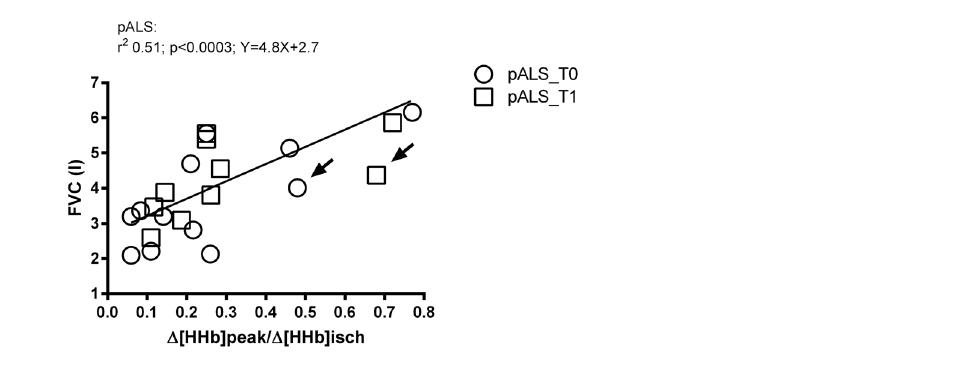
Figure 5. Correlation between orthostatic lung vital capacity (FVC) and vastus lateralis O 2 extraction ( Δ [HHb]/ Δ [HHb]isch) at exhaustion, at baseline (T0) and after 4 months (T1), in pALS. White circles: pALS at T0; white squares: pALS at T1. Black arrow indicates 1 pALS with bulbar onset who was incapable of performing fully and correctly the spirometry